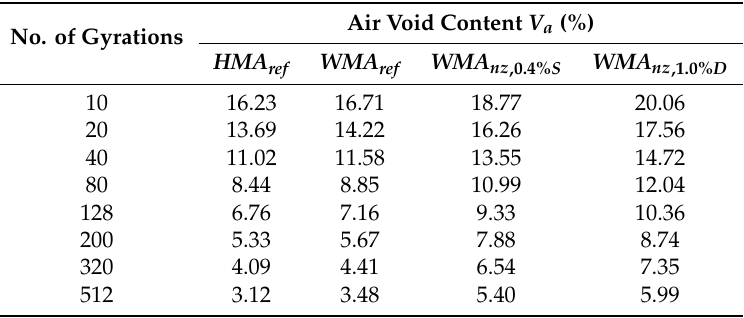
Figure 9. Results of the compactability analysis of the AC 16 mixes compacted in the gyratory compactor; mean values of the samples’ air voids content V a.